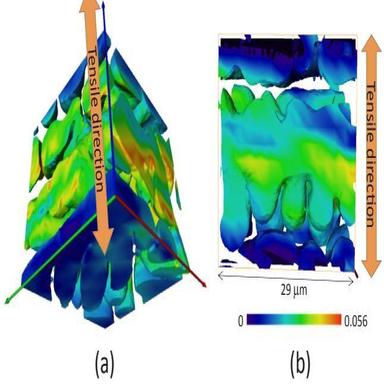
Strain obtained by DVC. (a) Tensile strain mapped on α-Al phase (eutectic phase was removed) and (b) Cross-section. Some strain concentration are seen at α- Al phase with ductility.